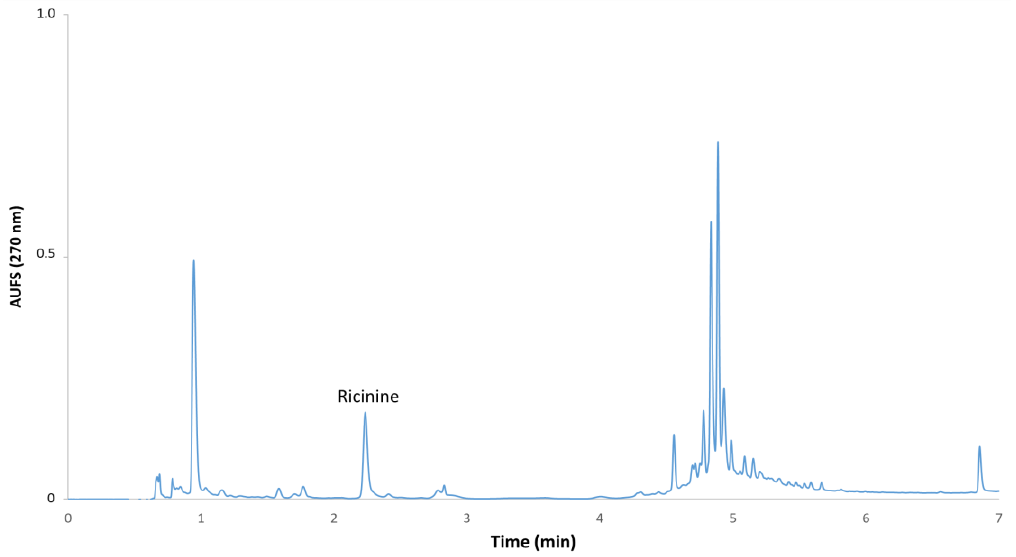
Figure 1. Resulting chromatogram from an extract from R. communis leaves.